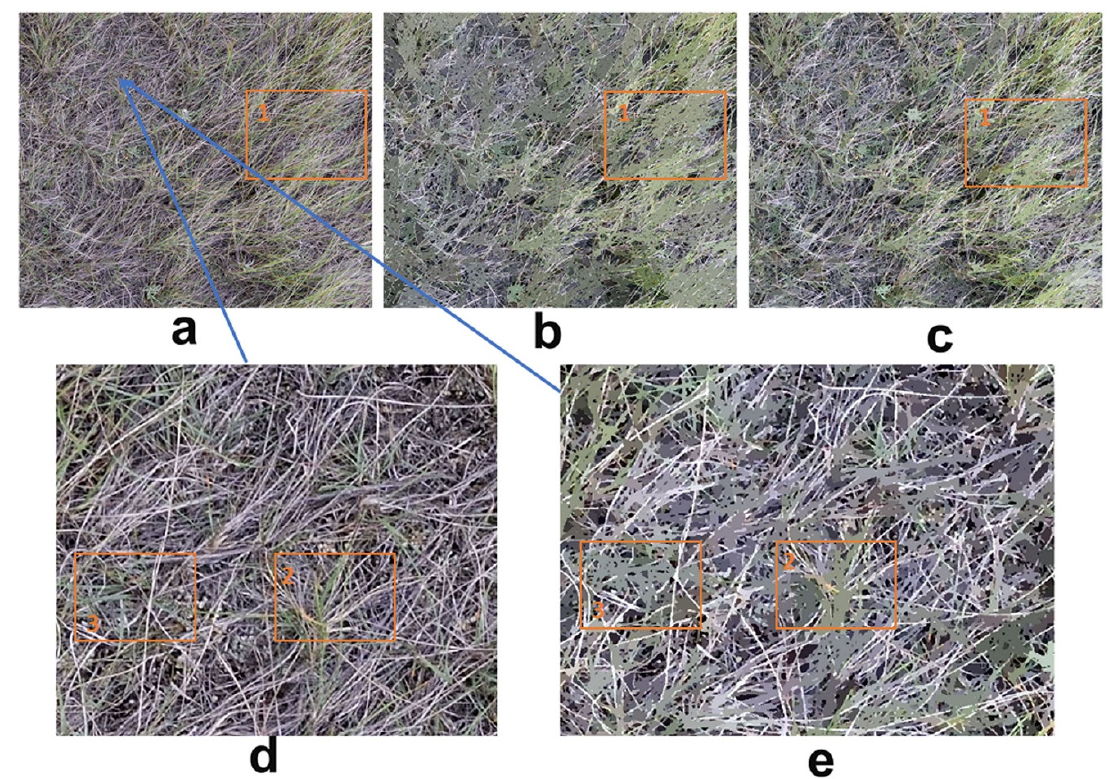
Figure 11. Illustration of spatial scale and merging-level effects on OBIA classification: ( a ) original image, ( b ) OBIA region mean scale was 60 and merging level was 10, ( c ) OBIA region mean scale was 40 and merging level was 5, ( d ) subset of ( a ), and ( e ) subset of ( b ). ( a ) was from site UG2, plot S5 (needle-and-thread-grass ( Hesperostipa comata ) dominated). Table 2. p -value of the paired-samples Wilcoxon test between in situ assessment and four other approaches (SamplePoint estimation, unsupervised classification, supervised classification, and object-based image analysis (OBIA)). SamplePoint 1